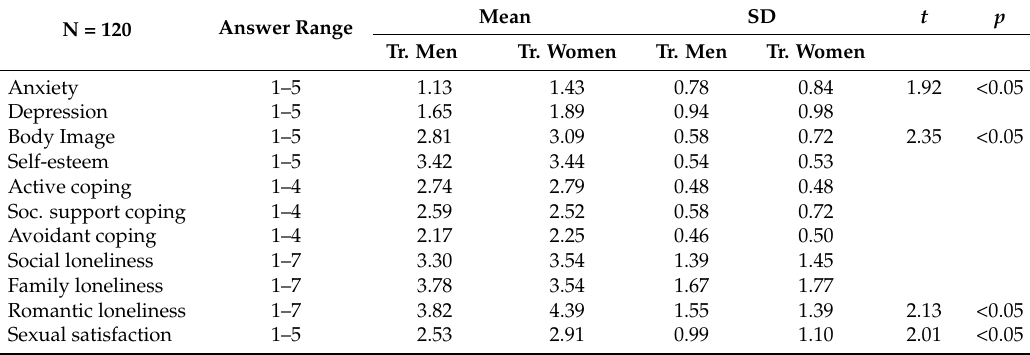
Table 1. Descriptive statistics for men and women in predictor and outcome variables. N = 120